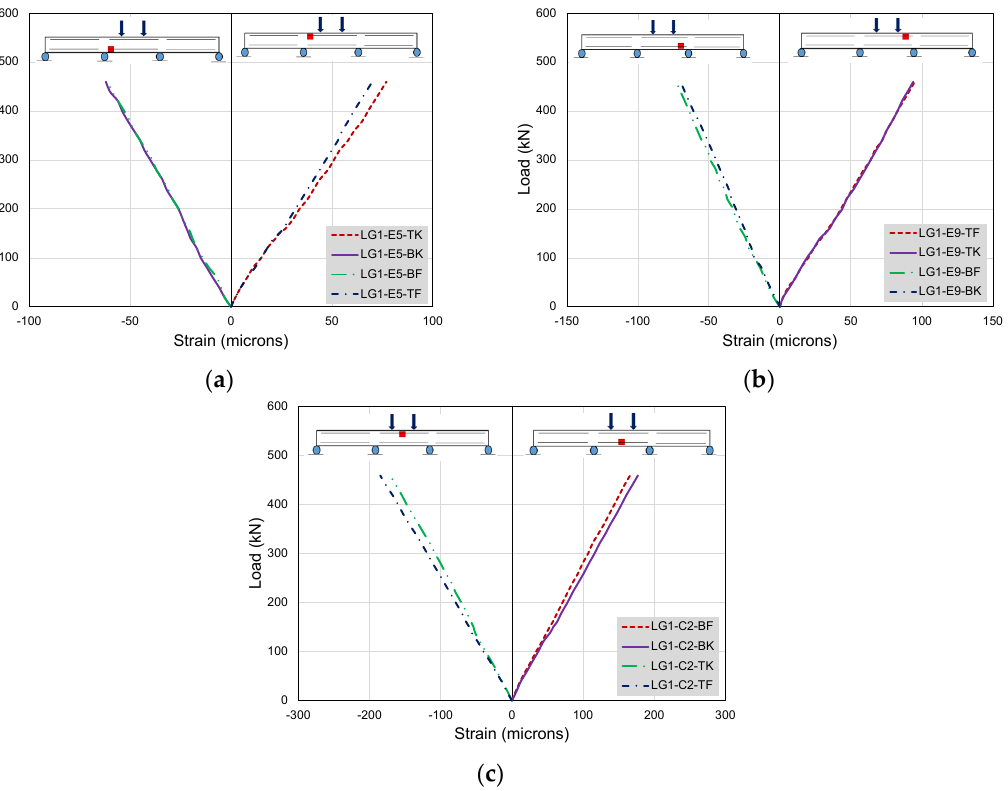
Figure 16. Strain versus load responses at locations ( a ) E5, ( b ) E9, and ( c ) C2. Loading Setup SP-1-L03